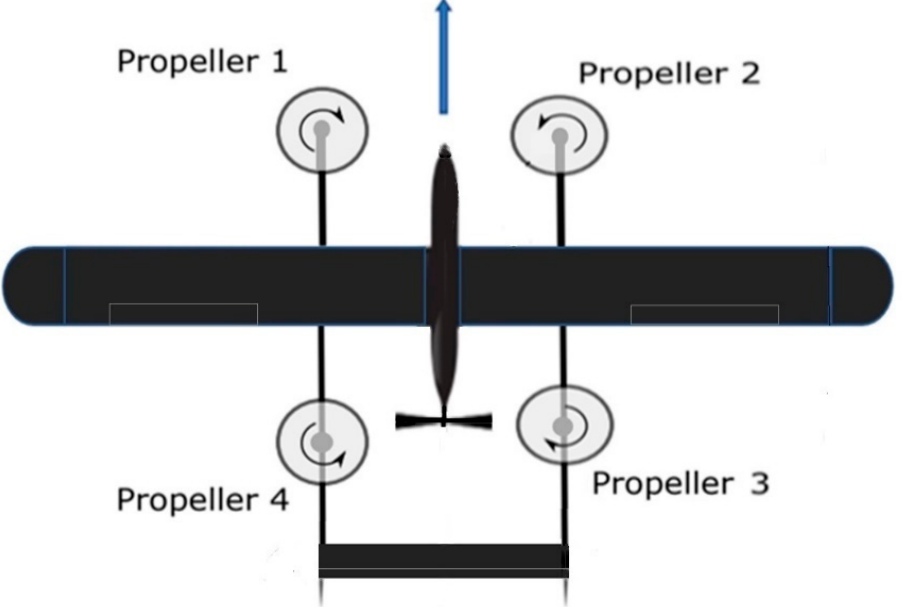
Figure 2. Quadplane rotors configuration.